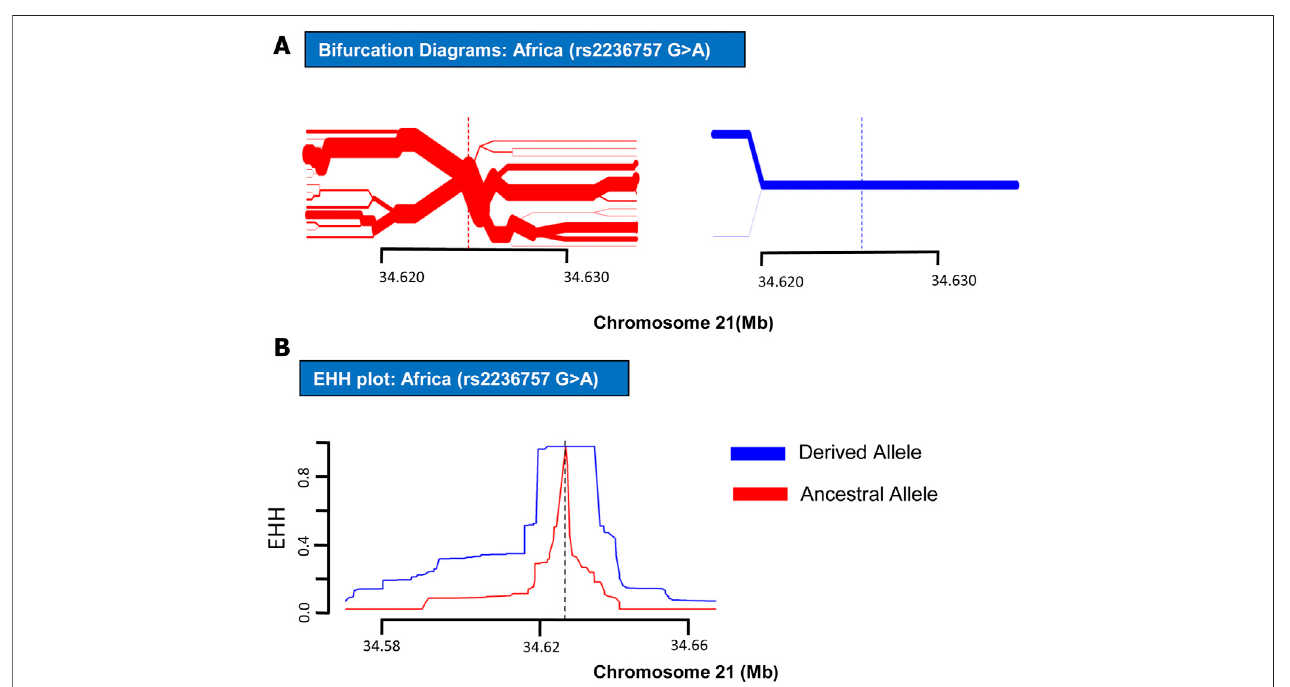
FIGURE 2 | EHH plot and Bifurcation Diagrams for SNP rs2236757 (in African Populations). EHH plots and Bifurcation Diagrams of SNP rs2236757in African populations. (A) Bifurcation Diagram of the derived variant of the SNP rs2236757 (shown in blue) shows long haplotype and absolutely no branching at the nodes upto 14.6 kb region. (B) EHH plot for SNP rs2236757 shows derived allele A (shown in blue) is under positive selection. EHH = 1 indicates all haplotypes carrying either ancestral or derived state of the allele are matching upto this point.